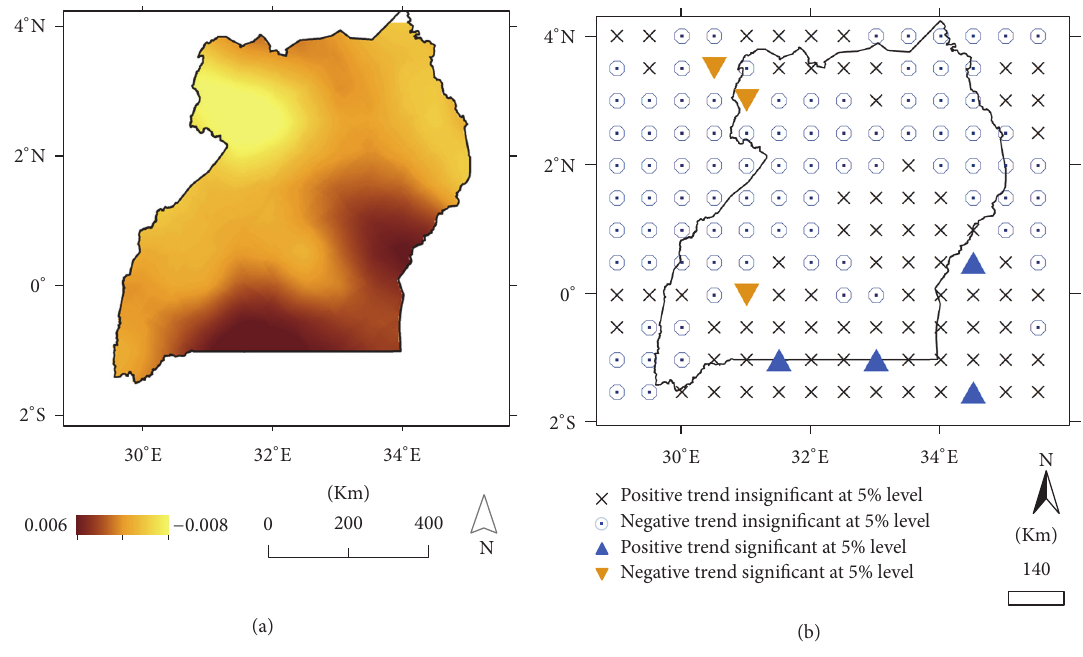
Figure 9: Trends in terms of (a) slope 𝑚 (mm/day/year) and (b)